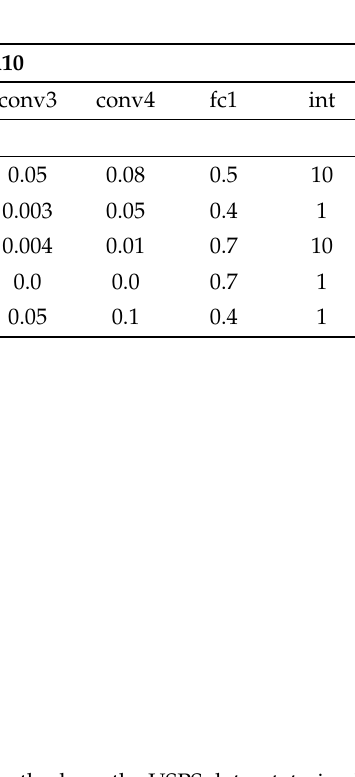
Figure 5. Performance of LIM and vanilla dropout methods on the USPS dataset, trained and tested for 100 epochs. Graphs were smoothed for better comprehension; original graphs can be seen in the background. Curves correspond to Table 2 scores. Black: vanilla, purple: 1, red: 2, orange: 3, green: 4, blue: 5. Table 2. Accuracy scores, parameter tuning, and convergence times for different experiments on the USPS dataset. The first row holds the best accuracy score for the vanilla dropout version and the epoch at which it was